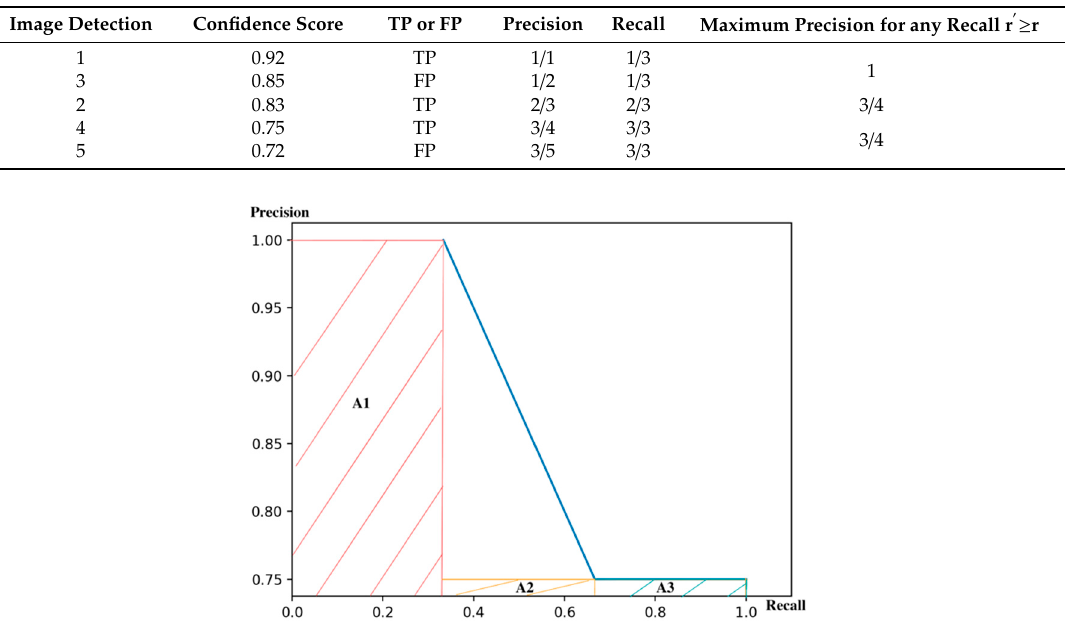
Table 2. Example detection results of one category.